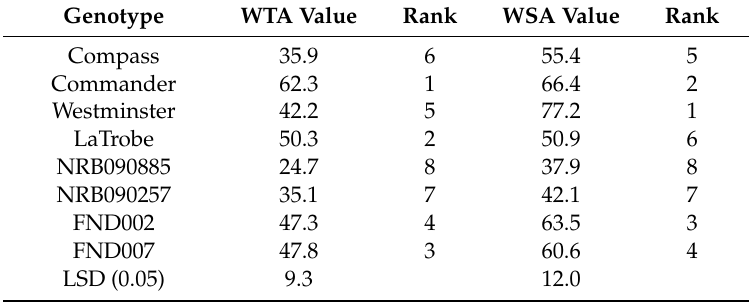
Table 5. Mean values for the weed-tolerance ability (WTA) and weed-suppressive ability (WSA). Genotype WTA Value Rank WSA